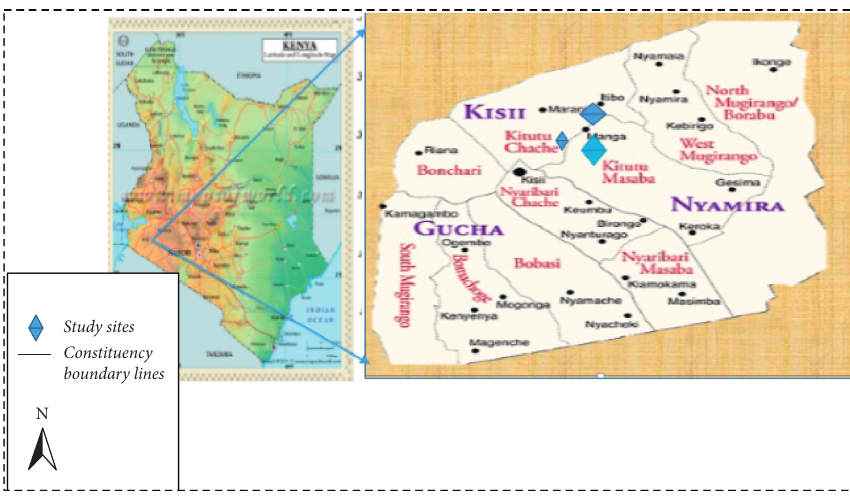
Figure 1: Map of Kenya showing the location of the Manga subcounty. Table 1: Water quality index and water quality status as adapted from [35–37].